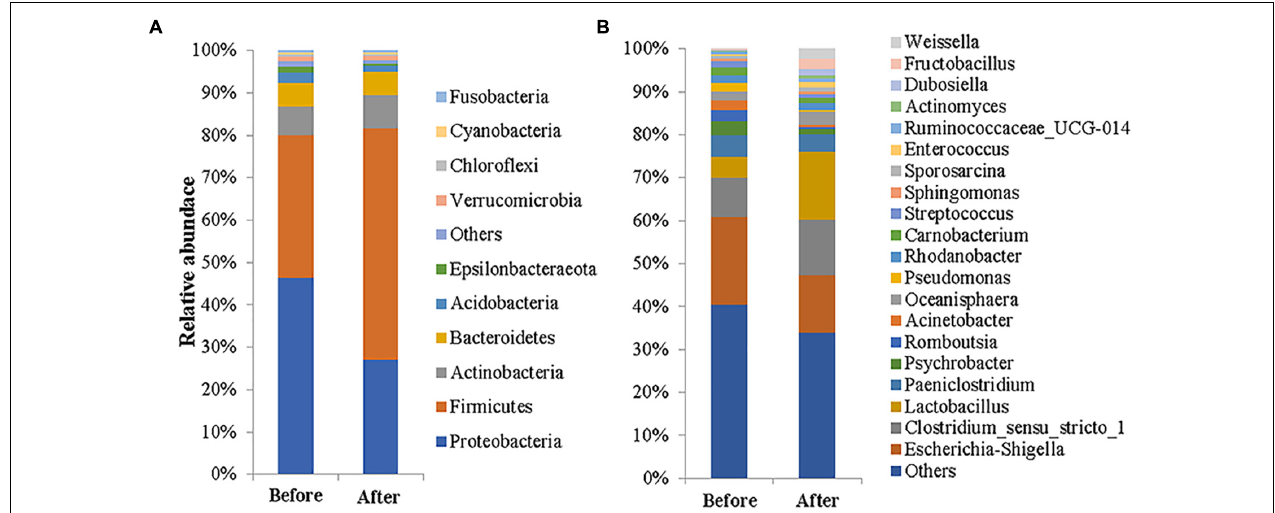
FIGURE 1 | Gut microbial compositions of the common kestrel before and after captivity. The compositions are presented as relative abundances at the phylum (A) and genus (B) levels.